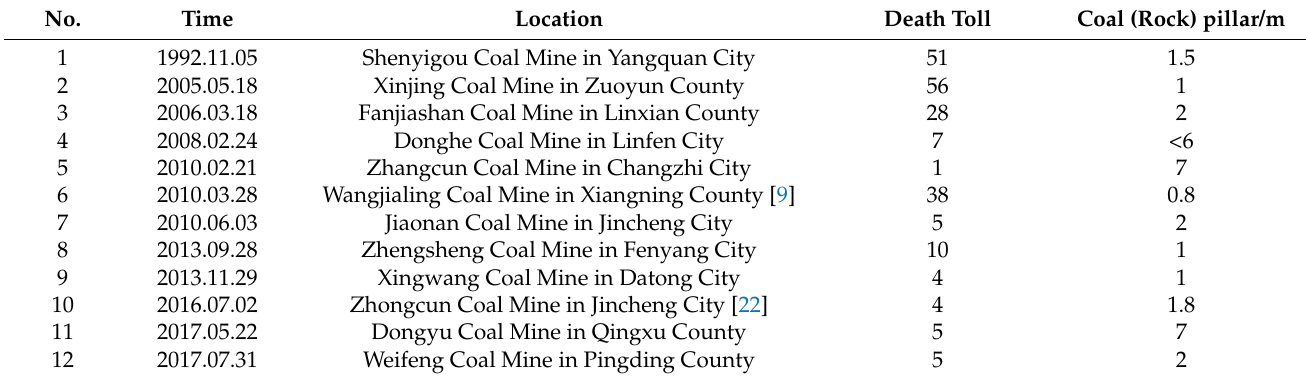
Figure 2. Distribution of 11 water inrush accidents in Shanxi and location relation diagram of adjacent mines of Dongyu coal mine. Table 1. Statistics of 11 major air water inrush accidents in Shanxi